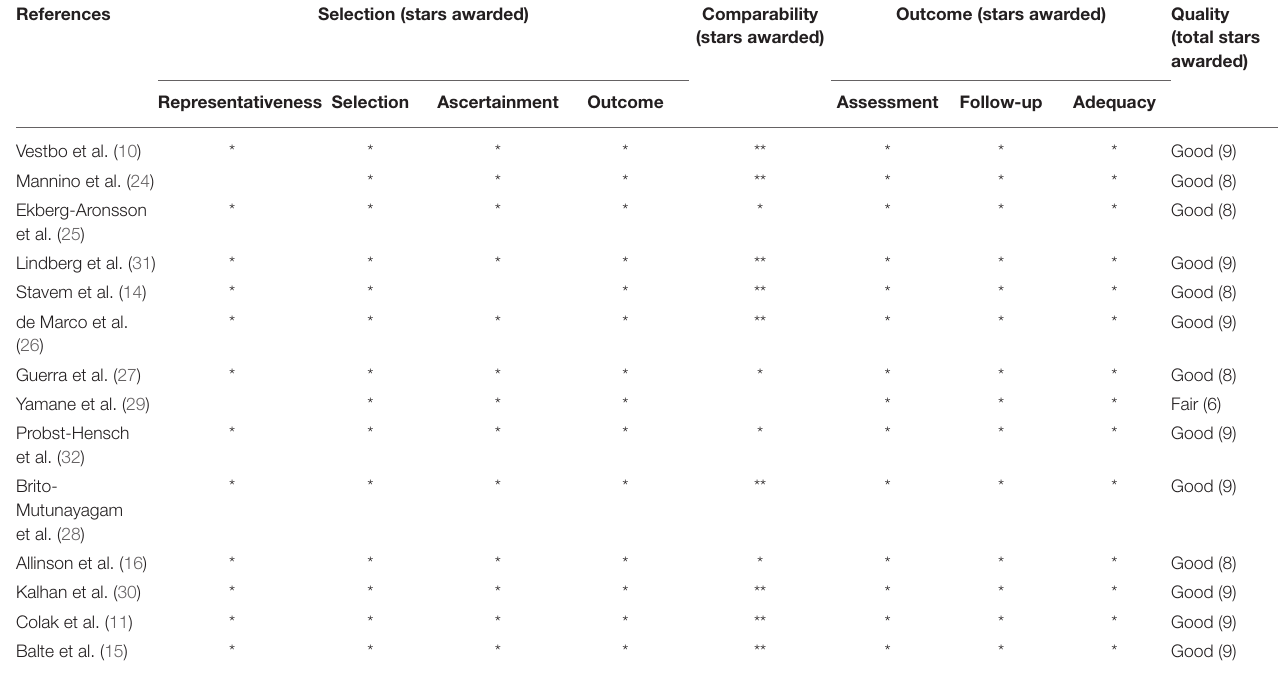
TABLE 2 | Newcastle–Ottawa Scale scores and quality assessment of all studies included in the